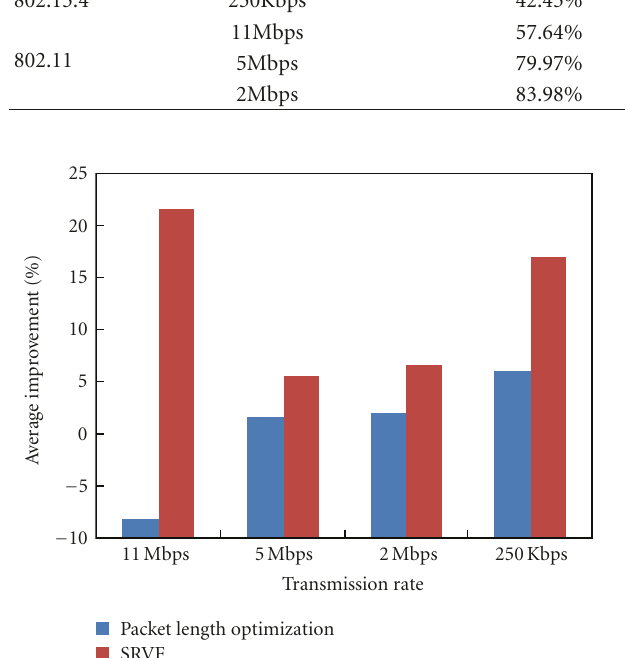
Figure 6: Average empirical improvement in energy consumption over Simple Positive-ACK.